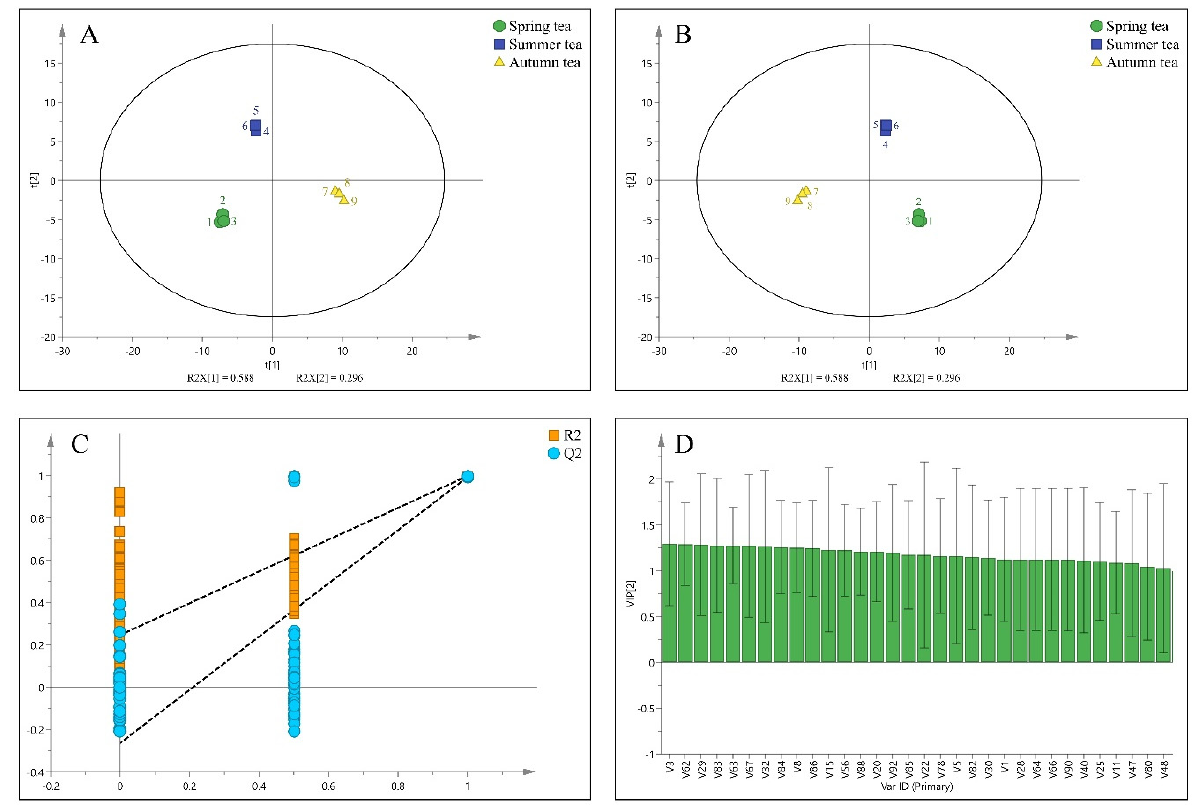
Figure 2. Multivariate analysis of spring, summer, and autumn tea samples: ( A ) PCA score plot; ( B ) PLS − DA score plot, R 2 X = 0.844, R 2 Y = 0.995, Q 2 = 0.991; ( C ) cross − validation plot of PLS − DA model with 200 times of calculations by using permutation test (R 2 = 0.276, Q 2 = − 0.259); and ( D ) the variable important in the projection (VIP > 1) key volatile components (numbers in Figure 2D are serial numbers of the aroma components in Table